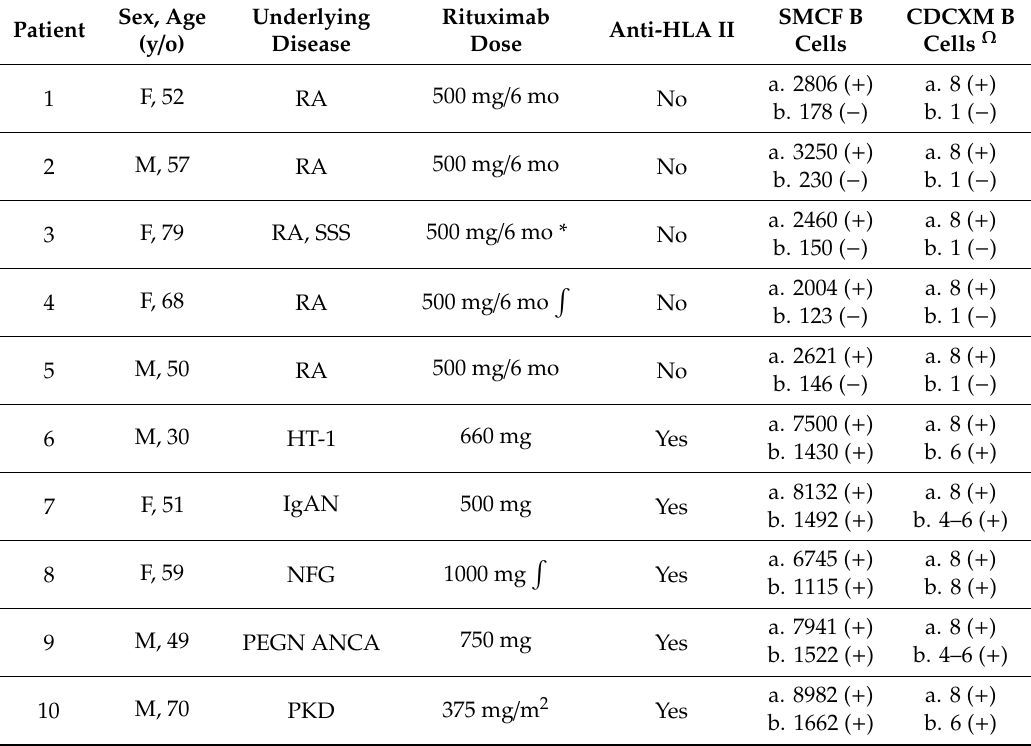
Table 1. Demographic data of the patients, rituximab doses and the results of the flow cytometry and complement-dependent cytotoxicity of the B cells and tested sera with and without the 10C5 clone anti-rituximab blocking antibody. Interpretation of both crossmatches (positive or negative) is indicated in both cases in brackets. SMCF (shift in median channel